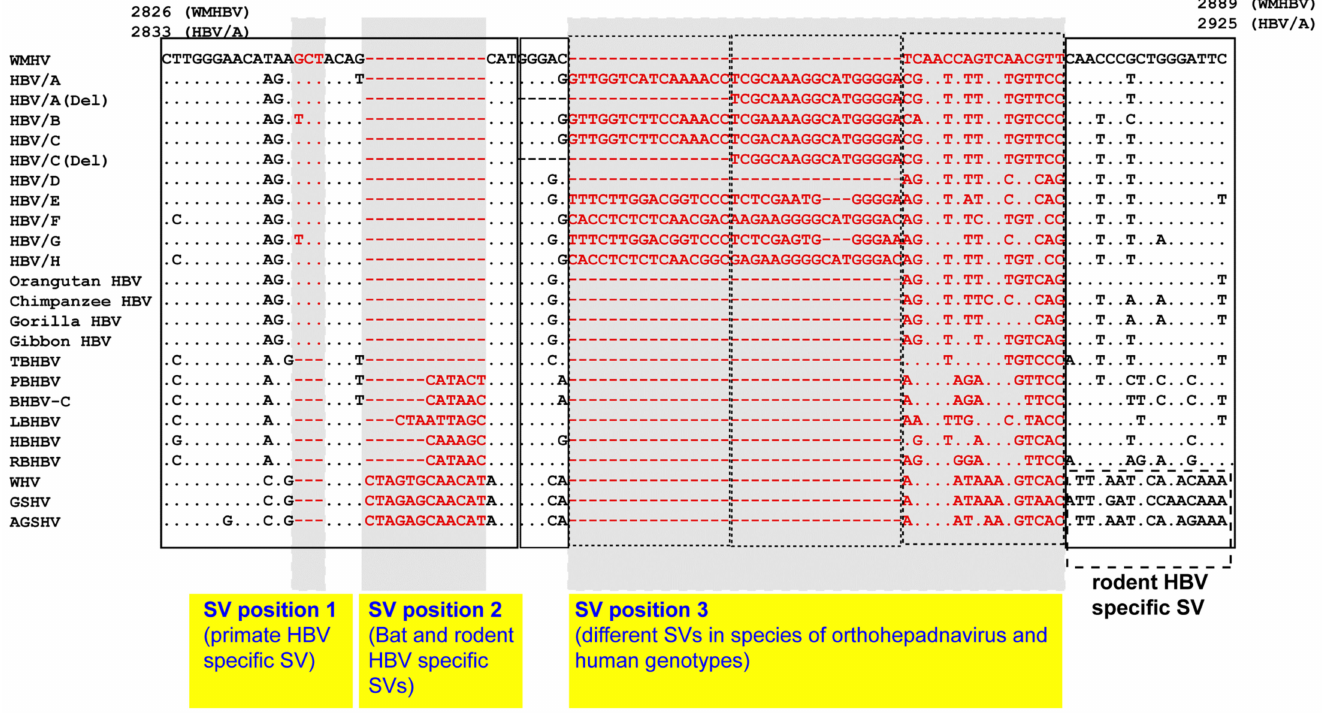
Figure 4. Alignment of the Pre-S1 ORF start site from nt 2826 to 2889 (WMHBV) showed different SVs in species with orthohepadnaviruses. Since multiple segments with SVs were observed in this region, the positions of SVs were designated as SV position 1 to 3. The SV polymorphisms in SV positions 1–3 change the length of amino acid residues of HBV polymerase spacer domain. Reproduced from reference 69, and modified. Details of the consensus genome sequences of human HBV and the non-human primate, bat and rodent HBV strains are provided in the legend to Figure 2. Genetic sequences of the strains are available in Reference